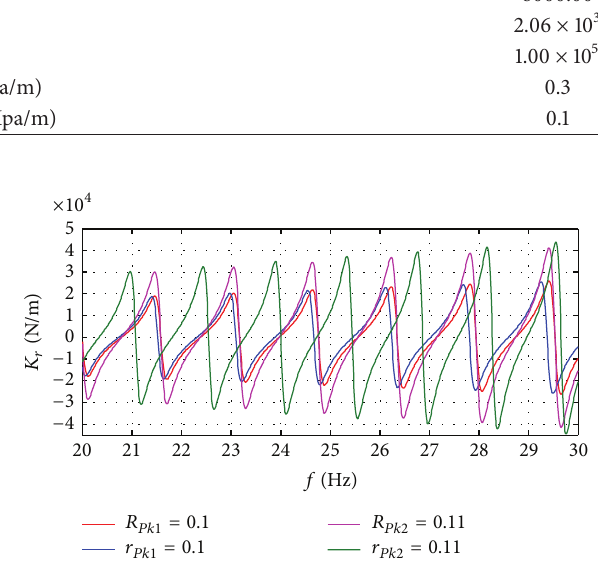
Figure 2: Influence of the drill string length on dynamic stiffness. Table 2: Calculation parameters of the length of drill string influence.